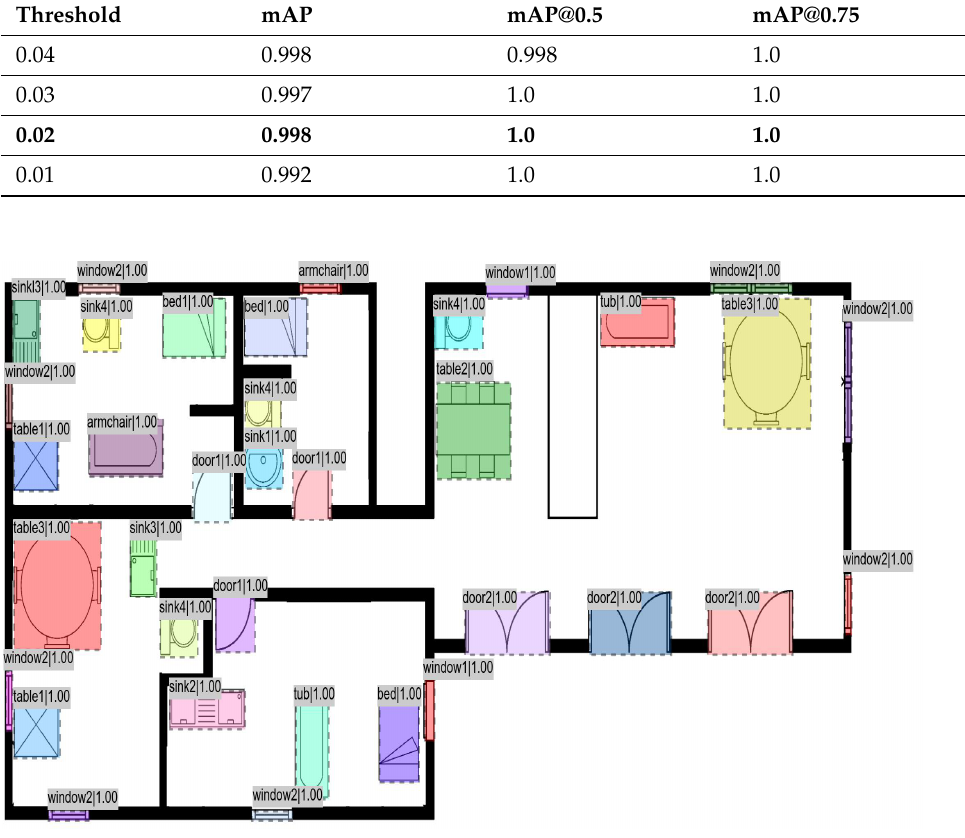
Figure 8. Test images where furniture items are miss-classified using Mask R-CNN [17] with ResNet- 101 [19] backbone on 10% label